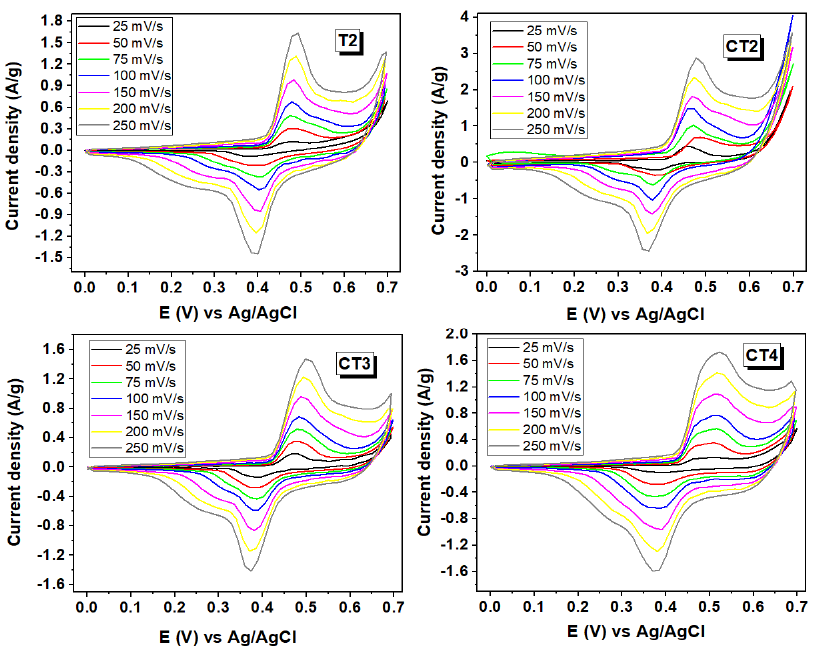
Figure 4. Cyclic voltammetry curves of pure TiO 2 ( T2 ) and 0.5% Cu ( CT2 ), 1% Cu ( CT3 ), 2% Cu ( CT4 ) doped TiO 2 nanostructures, at different scan rates.